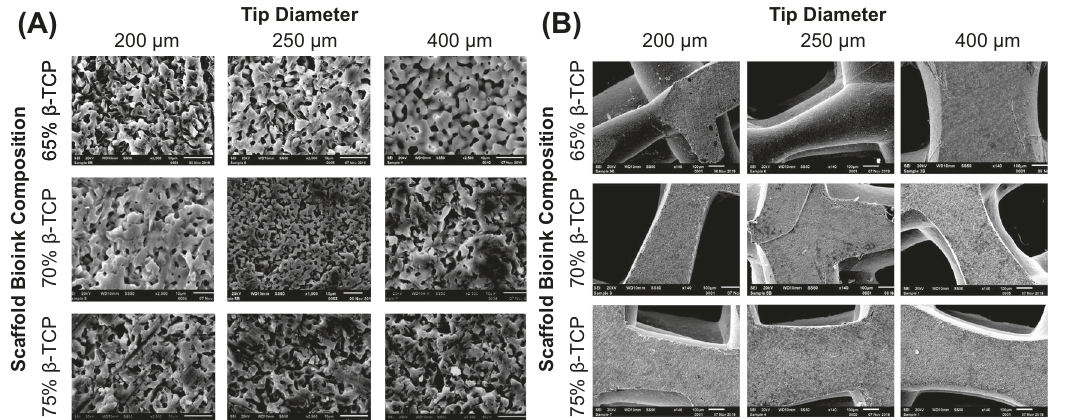
the struts is clearly distinguishable. b Low-magni fi cation (×140) images of the 3D-printed struts of the different scaffolds demonstrating structural